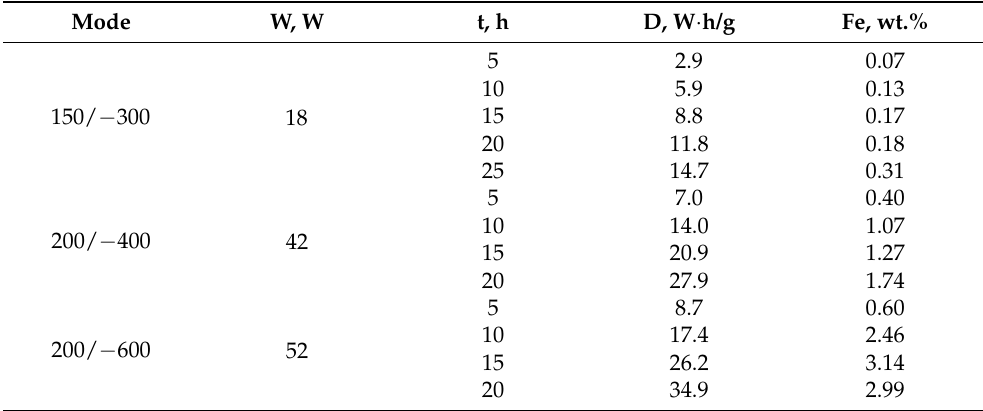
Table 1. Energy parameters of MA modes in the planetary mill and their influence on Fe-impurity quantity.